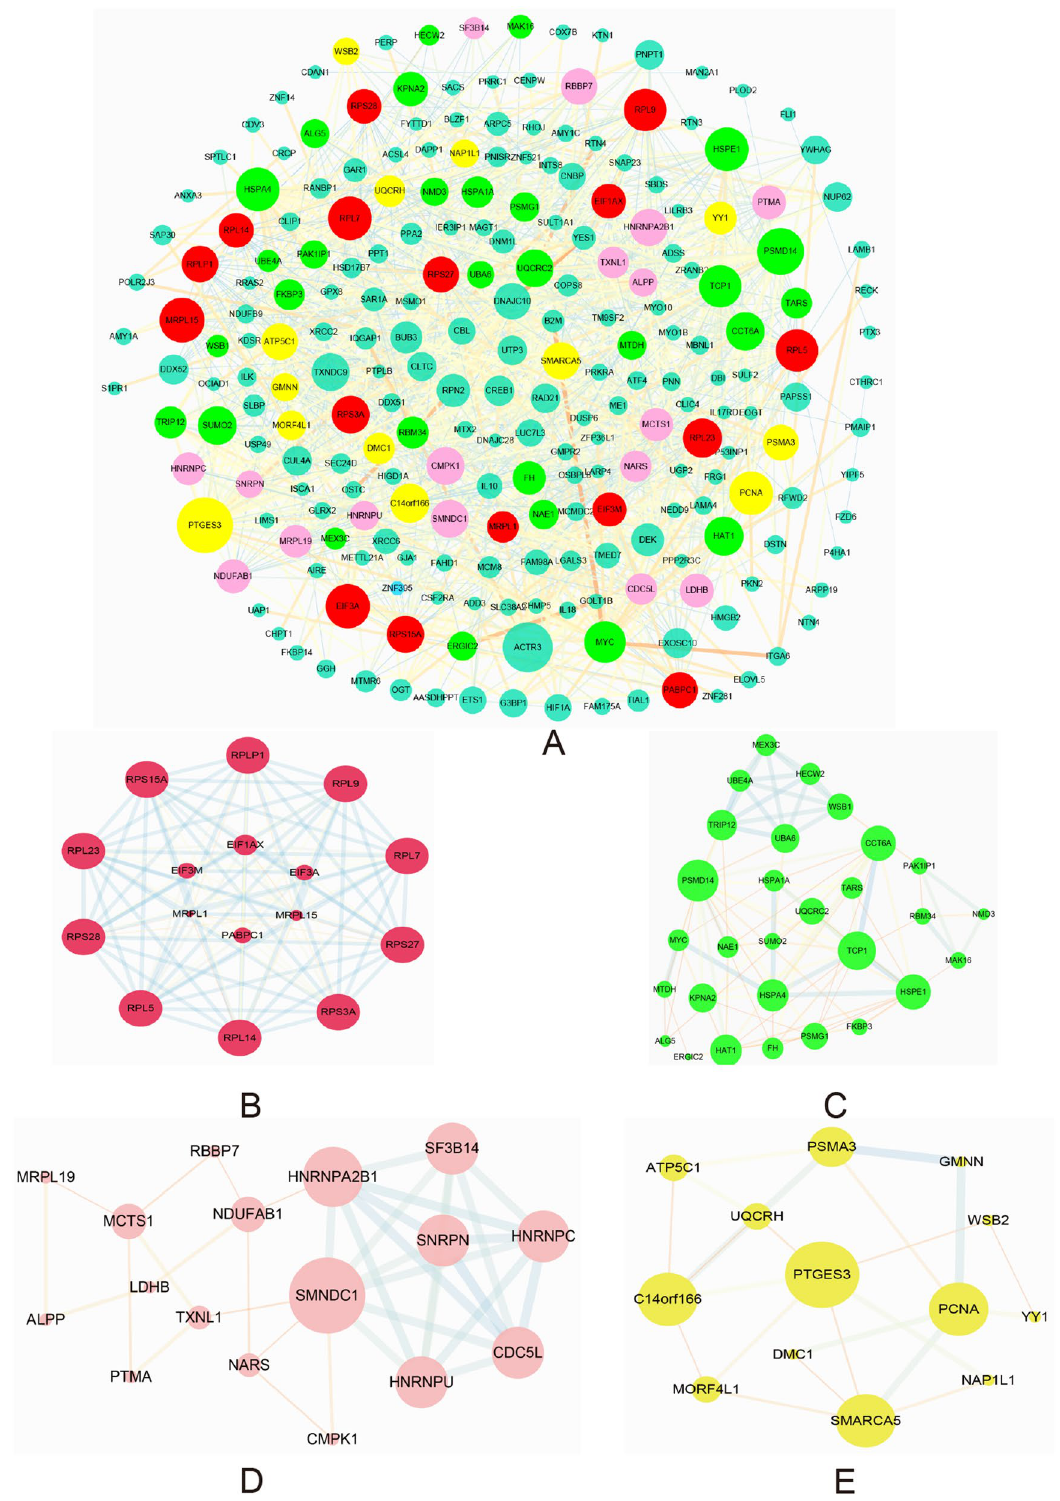
Figure 5. PPI network of the DEGs and module analysis. ( A ) PPI network constructed using 237 protein- encoding DEGs and 1105 edges. Node size indicates node degree, and the red, green, pink and yellow nodes represent module 1, module 2, module 3 and module 4 genes respectively. ( B ) Module 1 consists of 16 nodes and 113 edges. ( C ) Module 2 consists of 29 nodes and 90 edges. ( D ) Module 3 consists of 17 nodes and 36 edges. ( E ) Module 4 consists of 13 nodes and 22 edges. In module analysis, node size indicates node degree, edge size and edge color based on combined score. Protein–protein interaction, PPI, Differentially expressed genes, DEGs. Created with STRING soft version 11.0 (https:// string- db. org) and cytoscape software 3.6.1 (www. cytos cape.